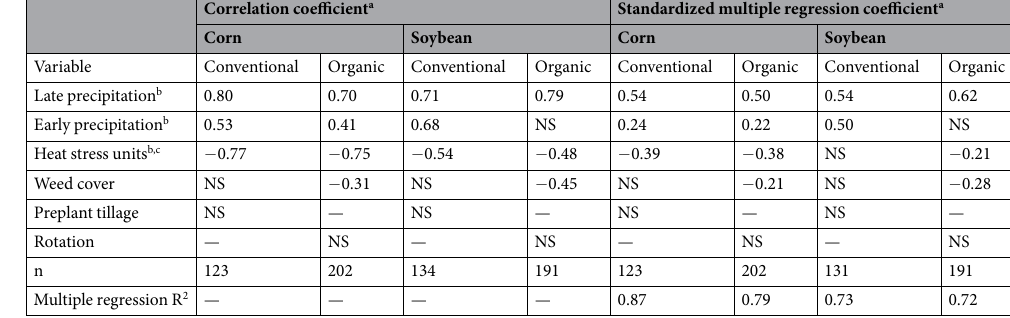
Table 1. Correlation and standardized multiple regression coefficients for crop yields with climatic and management variables. a Correlation coefficients are significant at P < 0.01. Multiple regression coefficients are shown for factors that were entered and retained in the model according to a stepwise selection procedure at P < 0.01. NS designates coefficients that were not significant. A dash indicates that the factor was not included in that analysis. b Precipitation and heat stress periods are defined in Supplemental Table S1. c Heat stress units are the accumulation of daily maximum temperature above 30